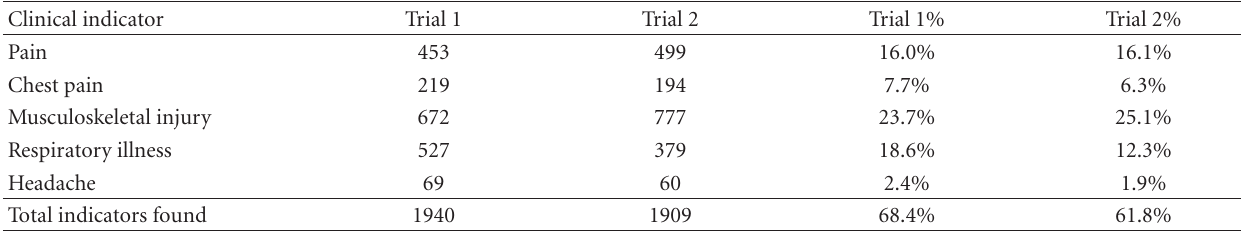
Table 5: Frequency of the presence of chosen clinical indicator.